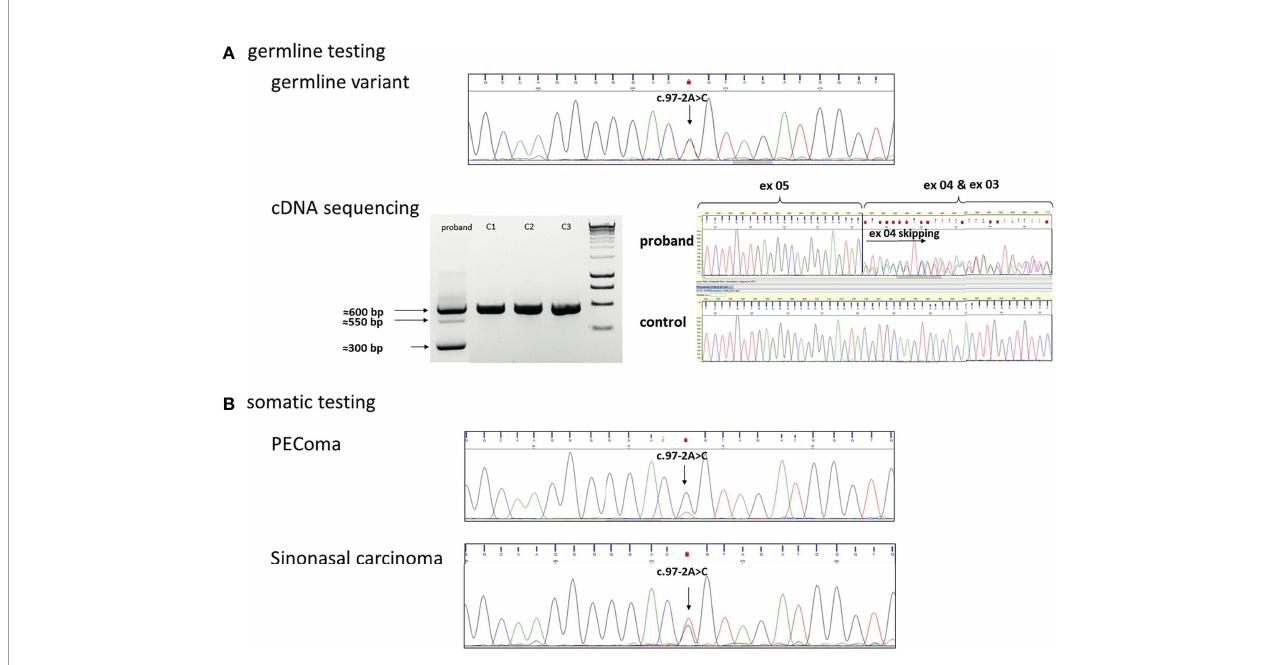
FIGURE 3 | (A) Germline heterozygous TP53 (NM_000546.5):c.97-2A>C variant in the DNA isolated from blood. cDNA sequencing identi fi ed exon 4 skipping, accordingly. On the electrophoresis gel, the 600-bp PCR product indicates the wild type, the 550-bp PCR product indicates a heteroduplex, and the 300-bp PCR product was con fi rmed as a skipped exon 4 transcript following Sanger sequencing. (C1, C2, C3 were used as controls). (B) Sanger sequencing in the PEComa tissue sample indicated the loss of the wild-type (wt) allele in the tumor: loss of heterozygosity (LOH) was detected. In sinonasal carcinoma, wild-type and variant alleles are presented in ~50% – 50%: no LOH was